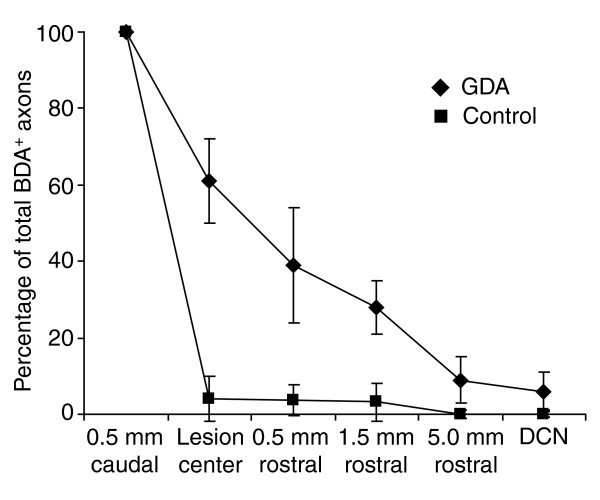
Quantification of numbers of regenerating BDA+ axons in GDA-transplanted versus control dorsal column white matter at 8 days after injury and transplantation. BDA-labeled axons were counted in every third sagittally oriented section within the lesion center and at points 0.5 mm, 1.5 mm, and 5 mm rostral to the injury site, up to and including the dorsal column nuclei (DCN). Note that 61% of BDA+ axons had reached the centers of GDA-transplanted lesions and 39% to 0.5 mm beyond injury sites, compared with just 4% (lesion center) and 3.8% (0.5 mm rostral) present in controls. The steady decline in numbers of BDA+ axons within rostral white matter indicates a staggered front of maximum axon growth beyond sites of injury in GDA-transplanted groups at this time point. Note the total absence of axons at 5.0 mm rostral and in dorsal column nuclei in controls. Counts of BDA+ axons labeled in all adjacent sagittally oriented sections in representative GDA-treated and control lesioned cords revealed totals of 372 and 330 axons, respectively, at 0.5 mm caudal to the injury site. Increases in numbers of BDA+ axons in GDA-treated animals compared with controls were statistically significant (p < 0.01) in all rostral spinal cord regions. Error bars indicate ± 1 standard deviation.